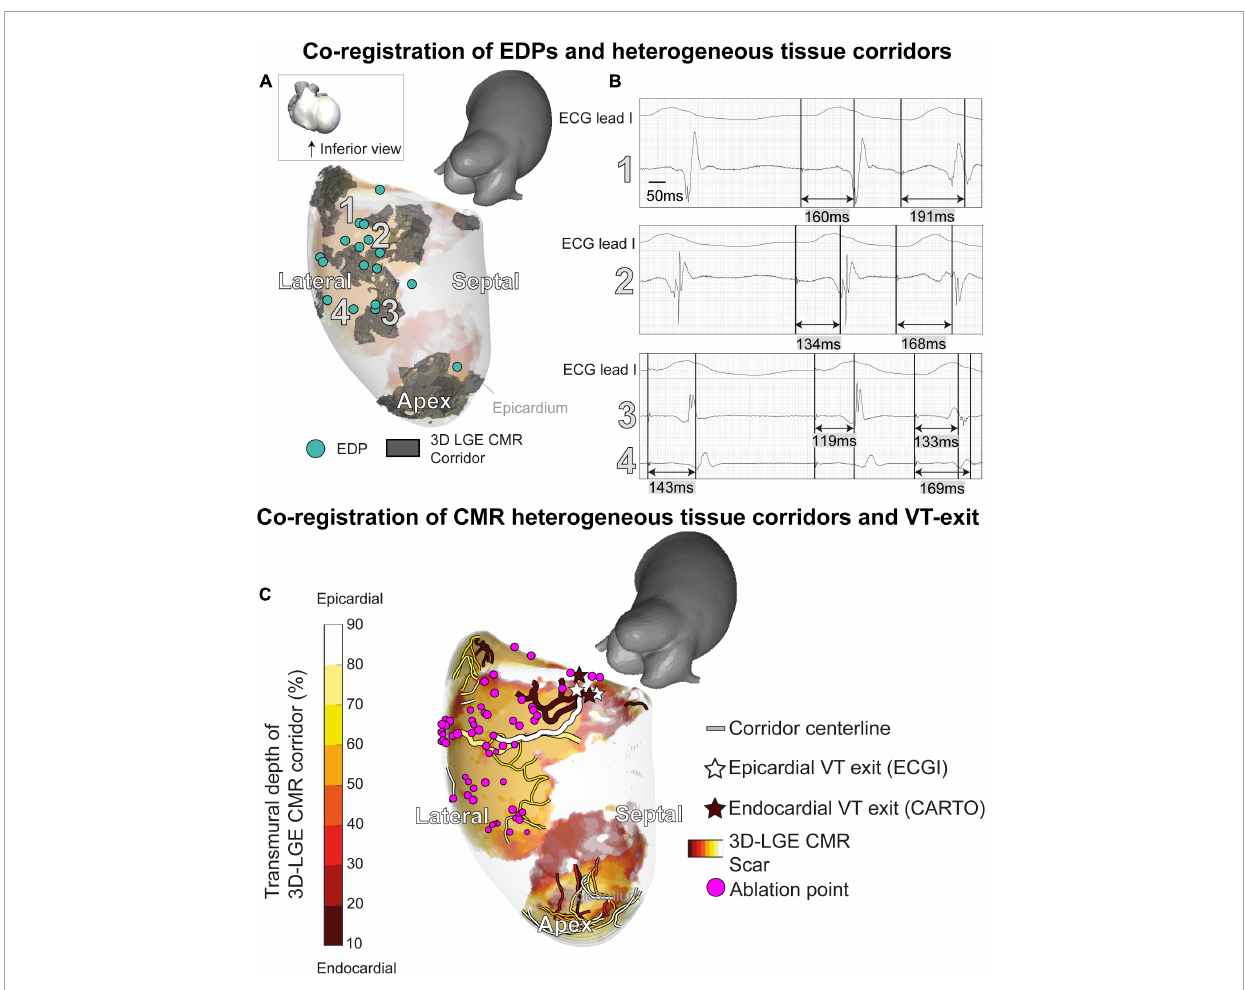
FIGURE4 A 3D-late gadolinium enhancement cardiac magnetic resonance imaging (LGE CMR) heterogeneous tissue corridors and evoked delayed potentials (EDPs). (A) Annotation of EDPs during the electroanatomical mapping (EAM) procedure, compared to a superimposed anatomical view of transmural heterogeneous tissue corridors detected through 3D LGE CMR. All EDPs except one coincided with ventricular scar or border zone. EDPs qualitatively coincided well with corridors close to the endocardium. (B) EDPs on locations 1–4 in panel A. (C) Investigating of ventricular tachycardia (VT) working mechanisms through structural-functional image overlay. Transmural layers of scar and border zone with centerlines of slow-conducting heterogeneous tissue corridors are superimposed and colored. VT exits were determined by pace mapping during the procedure. Invasively determined endocardial (brown) and non-invasively determined epicardial (white) exits coincide at the end of epicardial and endocardial corridors. Corridors of interest leading to the VT exit have an increased width. Ablation of the substrate (purple), including the identified corridors, rendered the patient